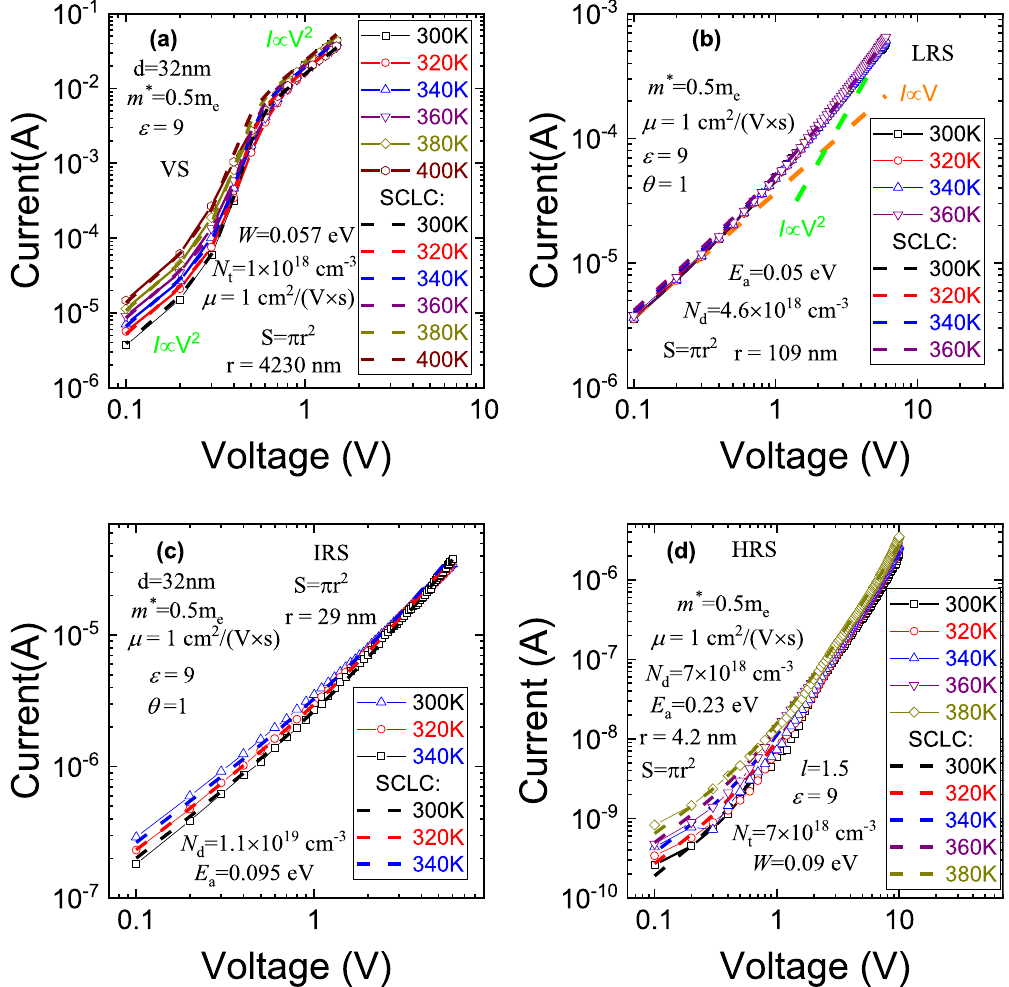
Figure 5. I–V characteristics and of p + -Si/SiN x /Ni and simulation by SCLC model in ( a ) VS, ( b ) LRS, ( c ) IRS, ( d ) HRS.